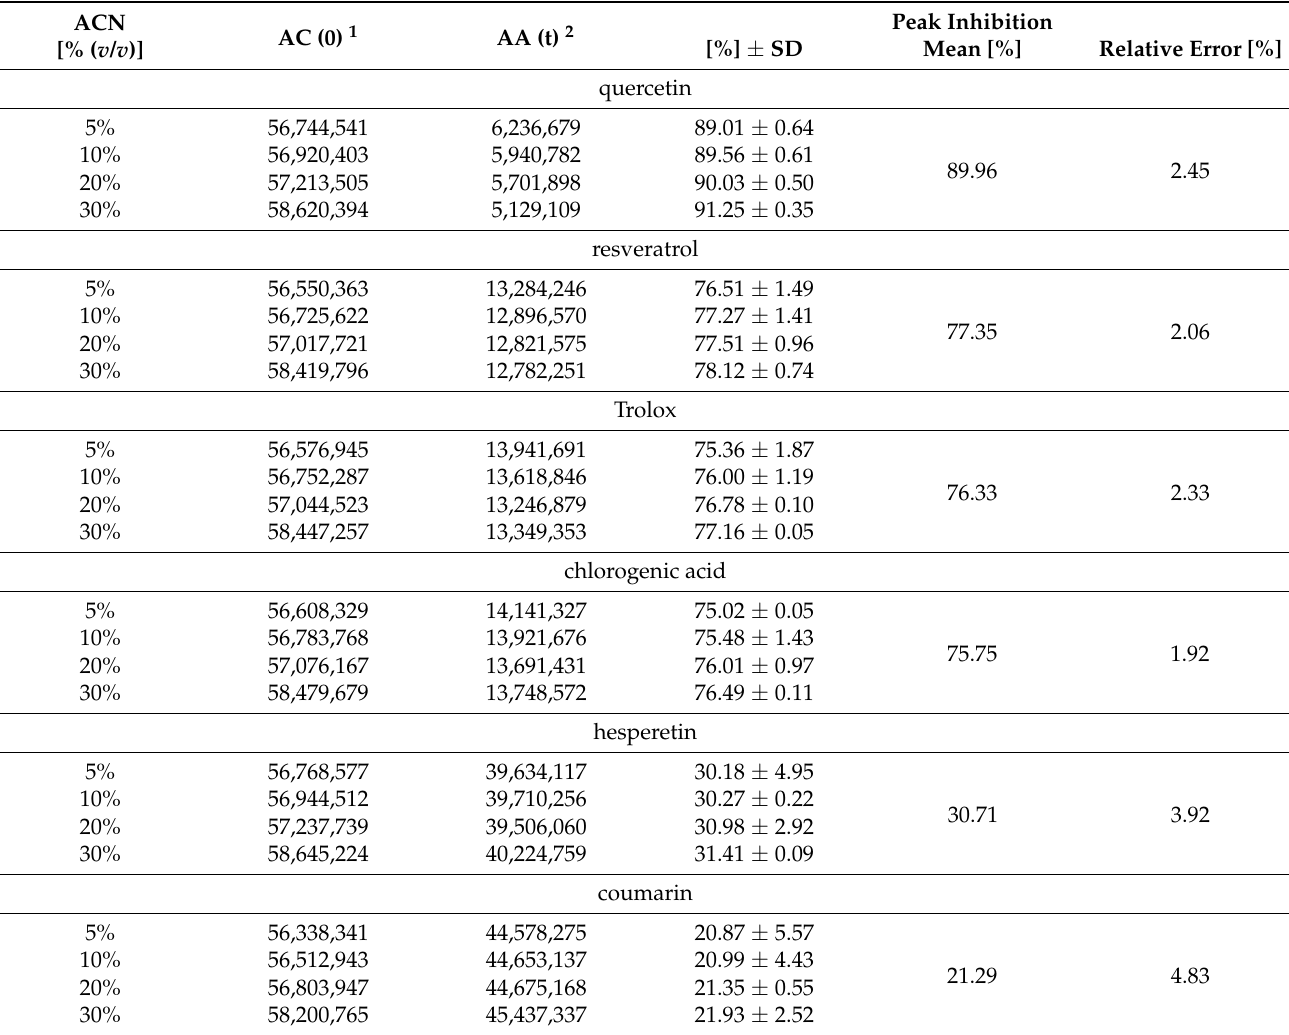
Table 2. Free radical scavenging activity of the studied compounds. Sample preparation: 417 µ L of 3 mM DPPH solution was mixed with 83 µ L of 3 mM AO solution and incubated for 50 min in the dark at room temperature. Chromatographic conditions: gradient elution from 5, 10, 20, and 30% ACN to 60% ACN within 20 min and a detection wavelength of 517